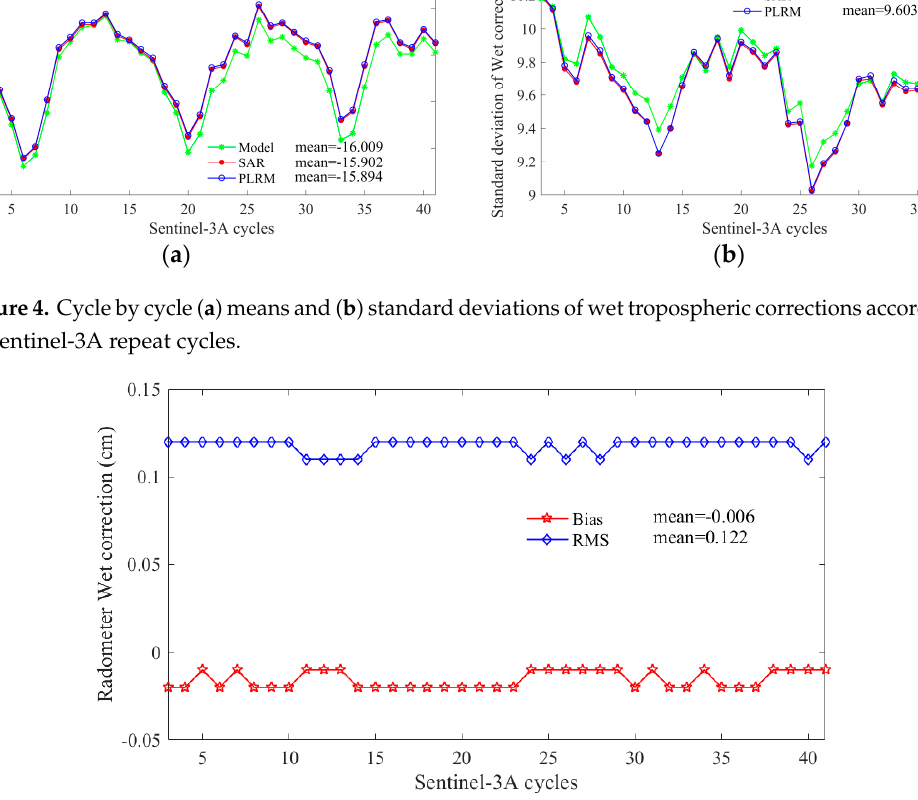
Figure 5. Cycle by cycle biases and RMSEs of differences of wet tropospheric correction between SAR and PLRM mode.